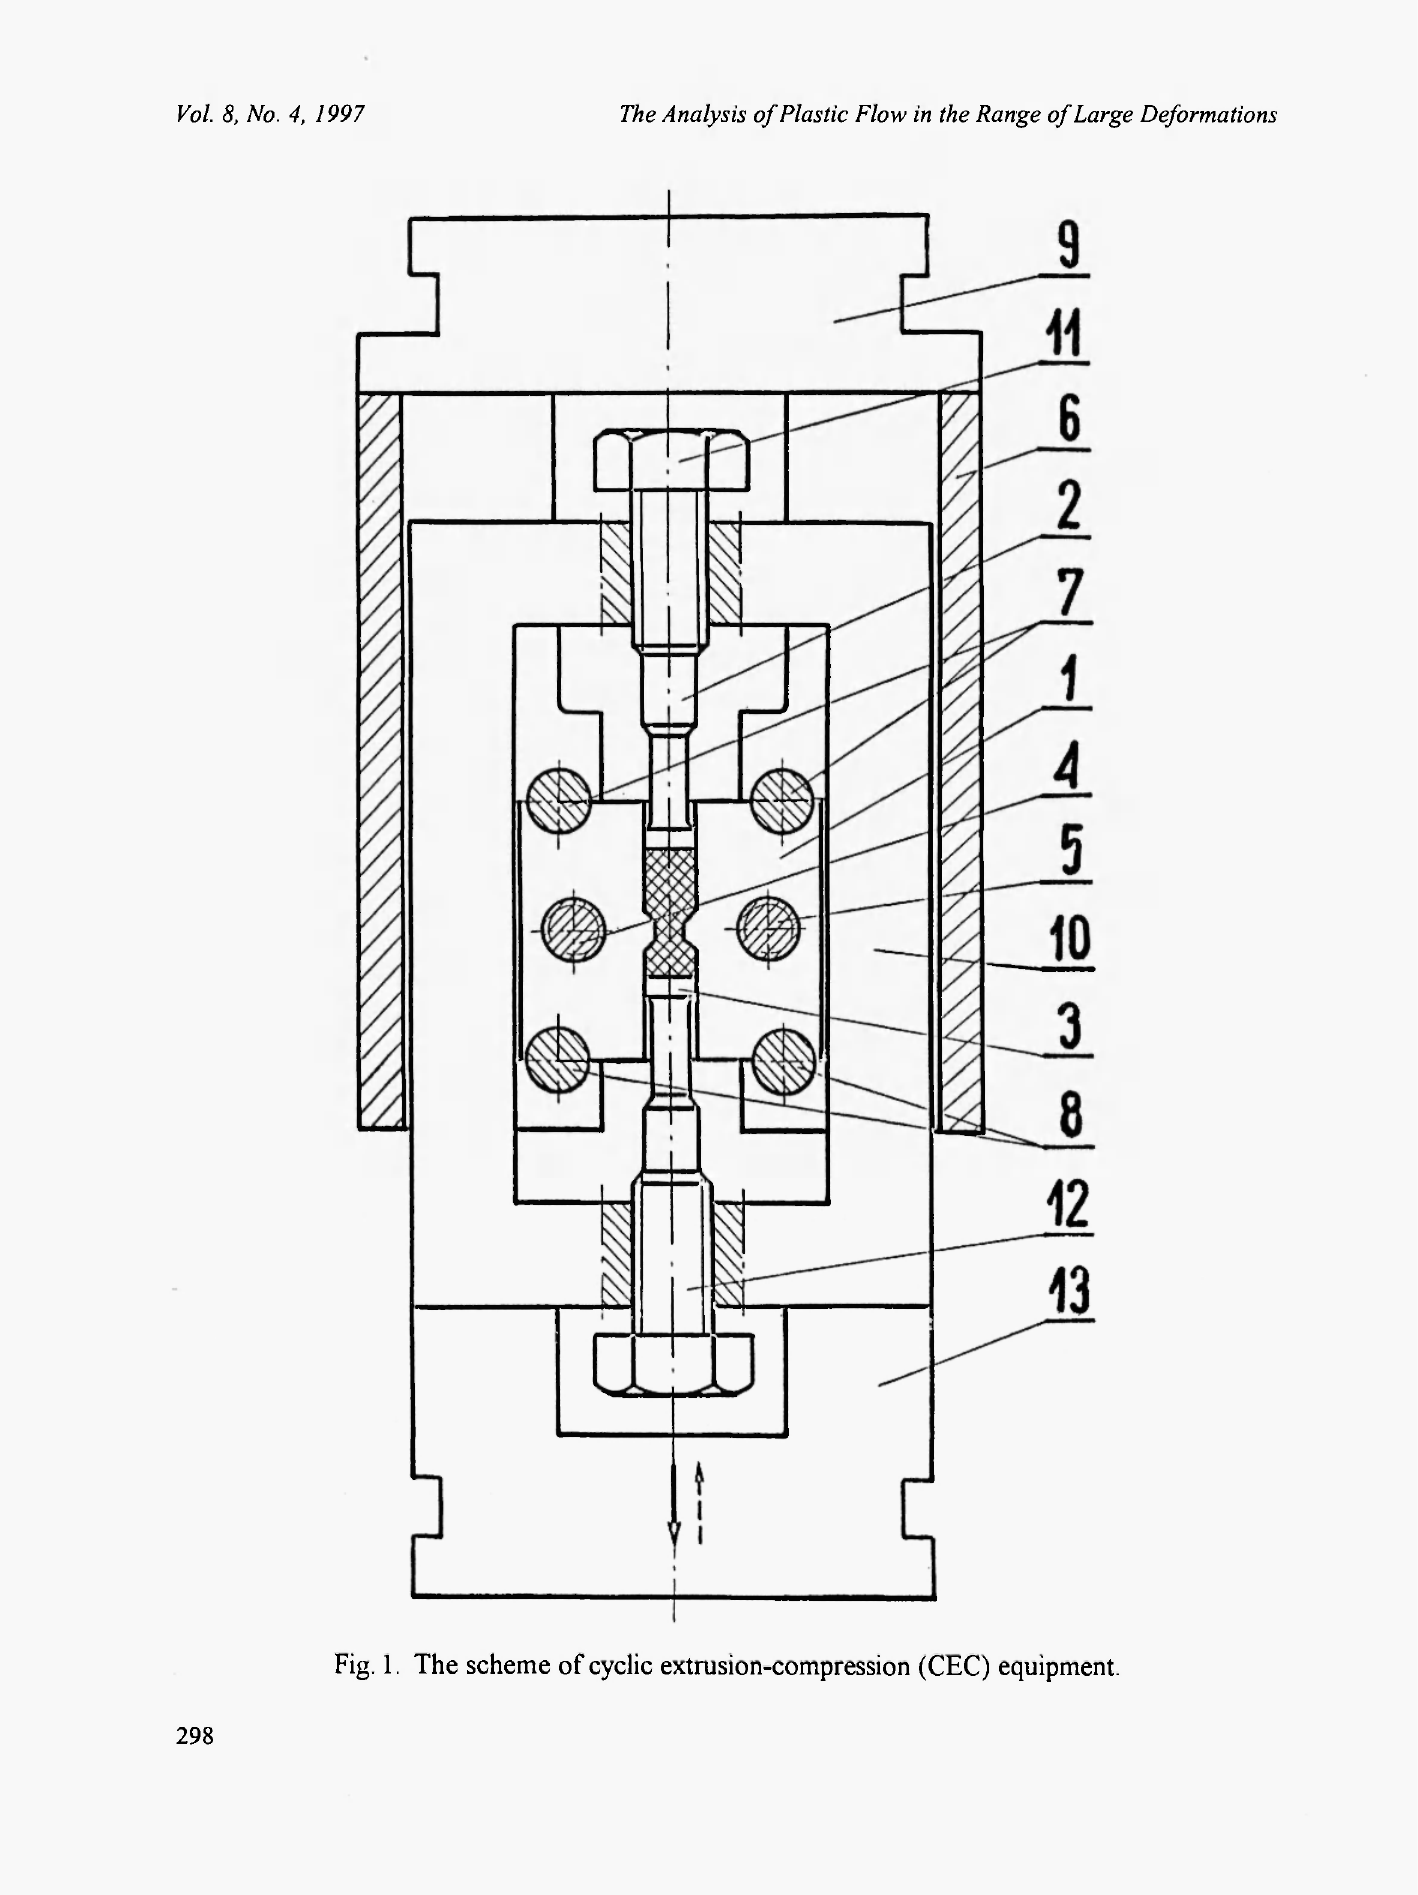
Fig. 1. The scheme of cyclic extrusion-compression (CEC)